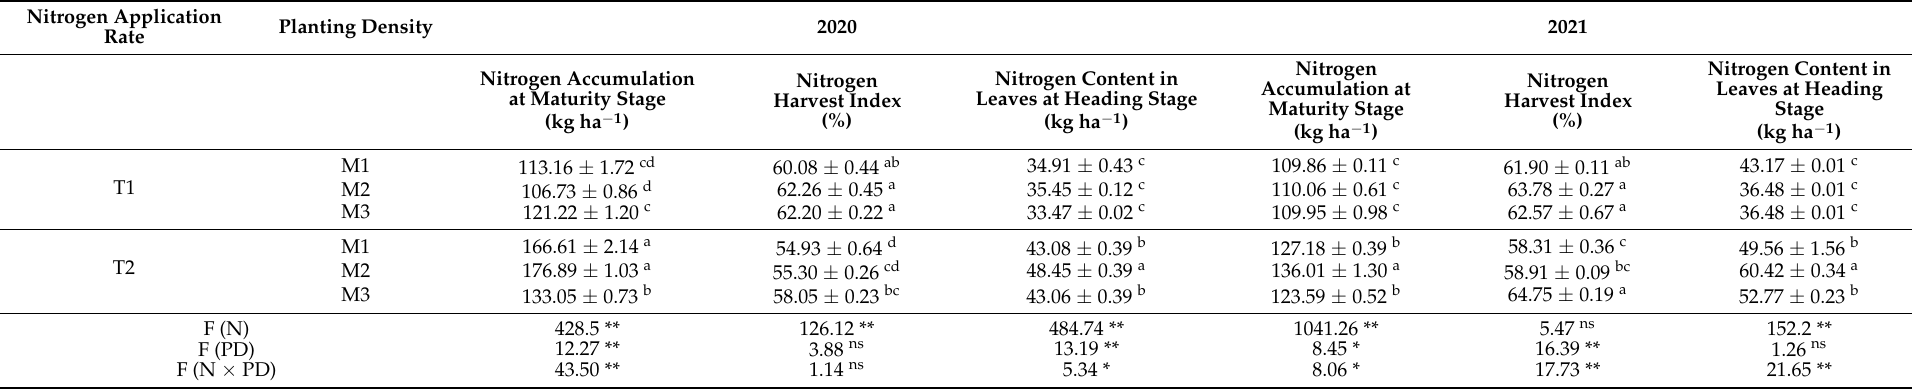
Table 4. Effects of different nitrogen application rates and planting densities on nitrogen accumulation, nitrogen harvest index, and leaf nitrogen content of